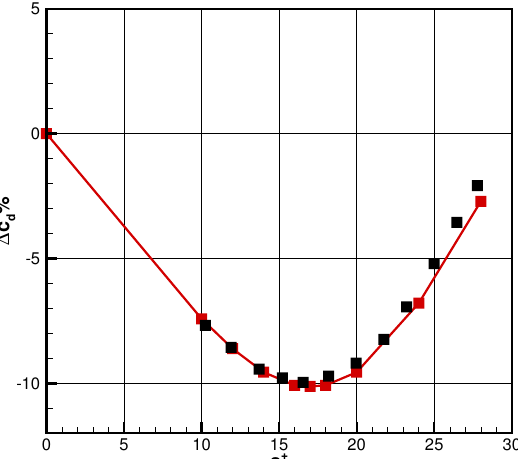
Figure 3. Blade riblets’ computed drag reduction vs. s + . Red: Equation (9),: (cid:4) experiment [7].